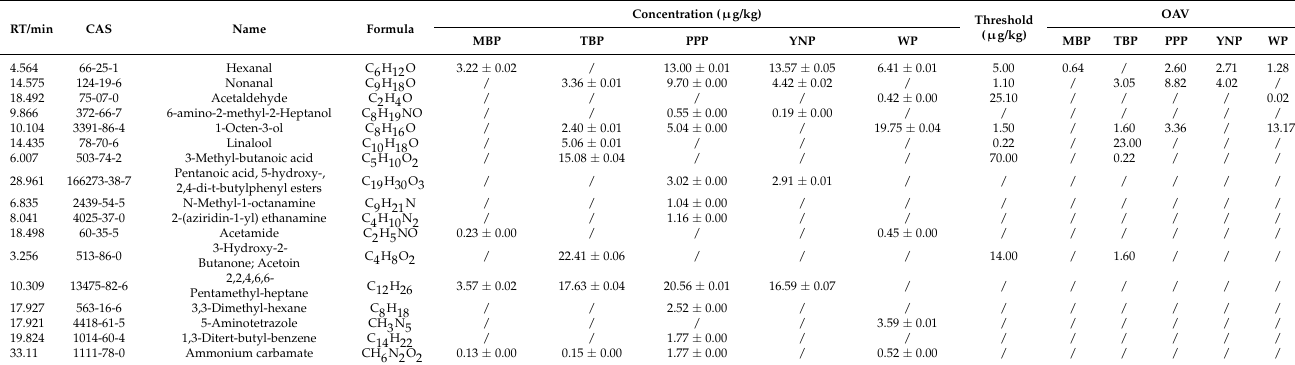
Table 7. The volatile aroma compounds of the five types of pork ( µ